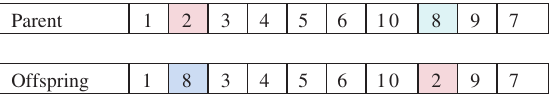
Figure 8: Example of Order Changing